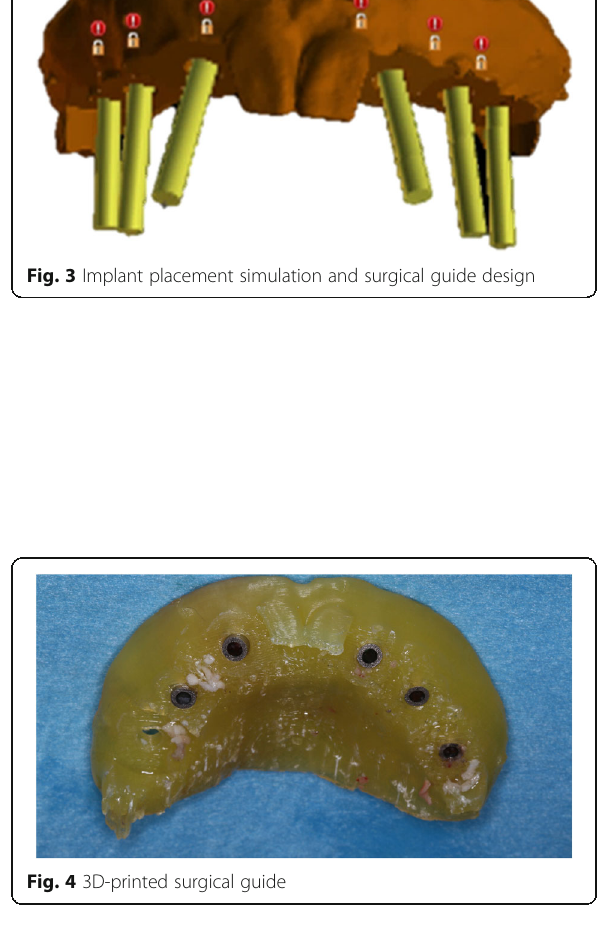
Fig. 2 Alignment of denture scan to patient ’ s maxillary CBCT scan